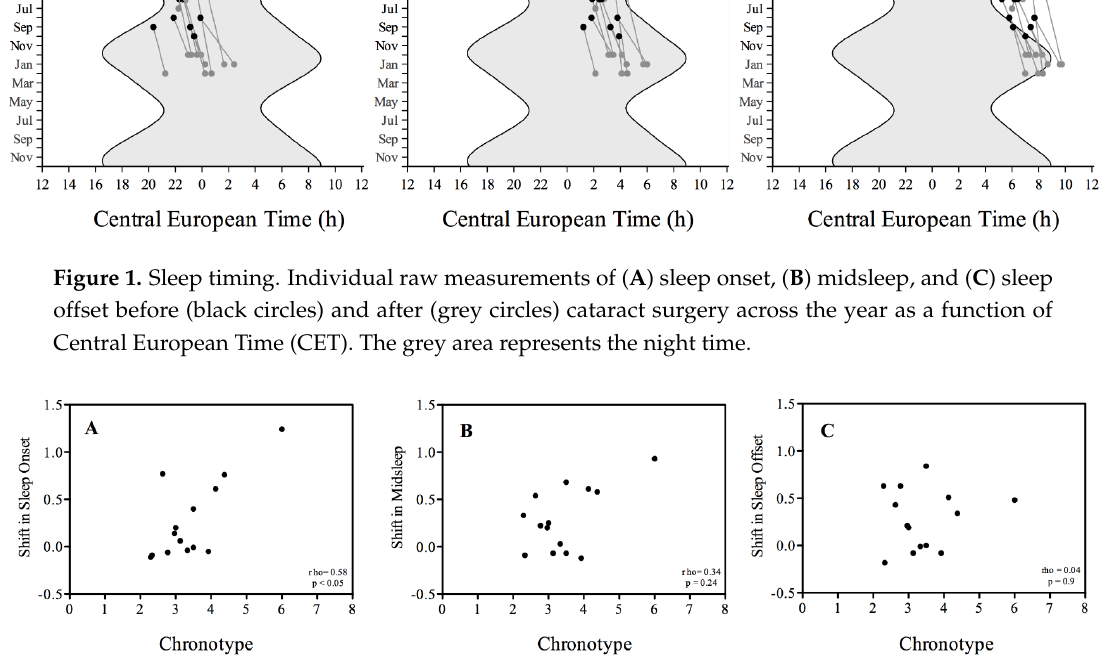
Figure 2. Correlations. Correlation (Spearman) among chronotype (MSF) and the difference between the before and after cataract surgery measurements of ( A ) sleep onset, ( B ) midsleep, and ( C ) sleep offset. Table 1. Sleep timing outcomes obtained by means of a combination of sleep diaries and actiwatch data after subtracting seasonal-confounding effects (see description in Section 3.2). Data are shown as average ˘ SD. N = 14. Before Surgery After Surgery F p Difference Sleep Onset (CET) 23:12 ˘